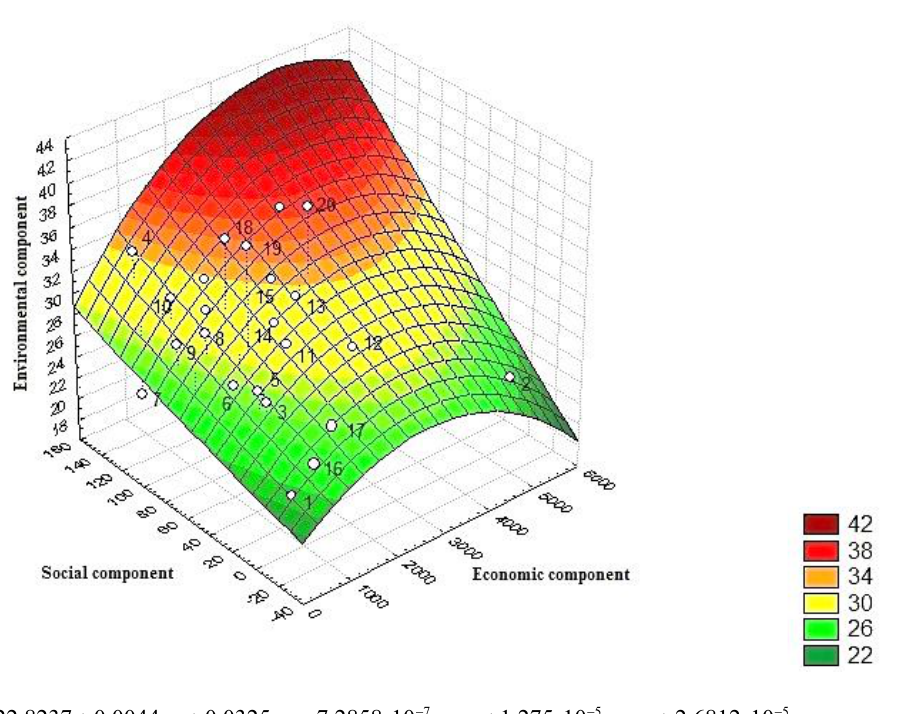
Figure 4. A three-dimensional positioning matrix to evaluate the level of CSR development at banks